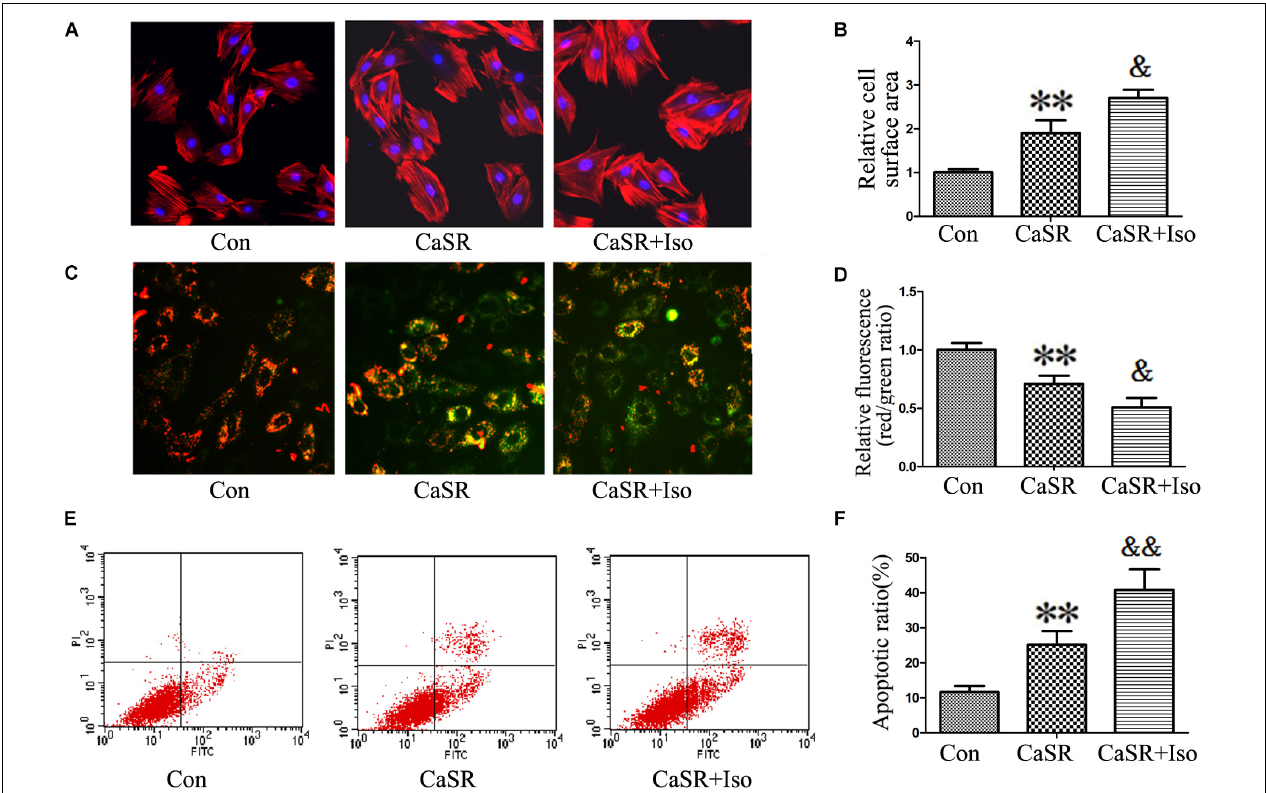
FIGURE 8 | Regulatory effect of CaSR overexpression on cell hypertrophy and apoptosis. (A,B) H9C2 cells were stained with rhodamine-labeled phalloidin and DAPI, and the cell surface area was measured and analyzed with LAS Software (V4.3) (Leica, Germany). The bars represent the cell size relative to that of the controls. (C,D) H9C2 cells were stained with JC-1, and the bars represent the fluorescence relative to that of the controls. (E,F) The level of apoptosis in H9C2 cells was examined using Annexin-V/PI staining and flow cytometry. The data are expressed as the means ± SEM, n = 4. ∗∗ P < 0.01 vs. the Con group; and & P < 0.05; && P < 0.01 vs. the shCaSR